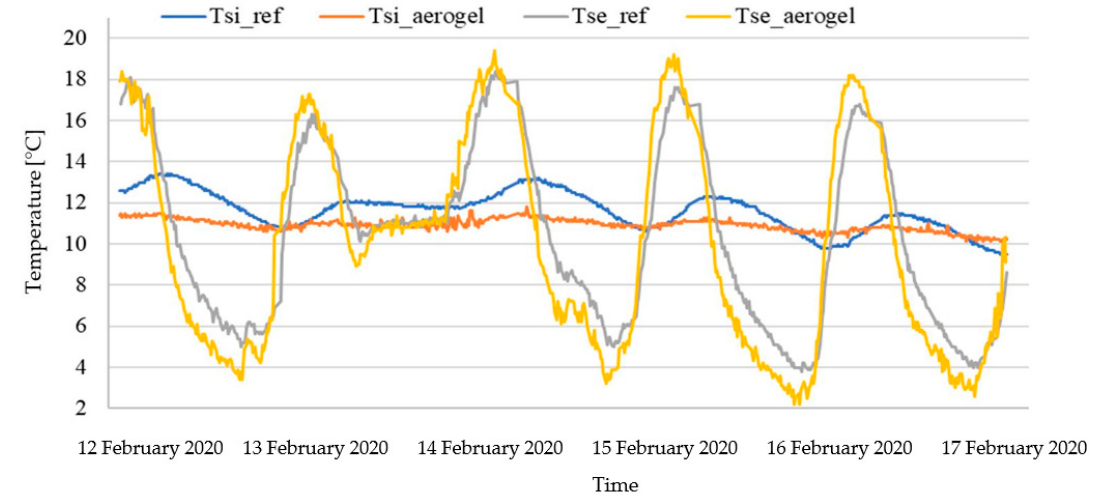
Figure 6. Internal and external surface temperatures of north-west walls registered for the insulated and the reference test rooms in the free-floating conditions.